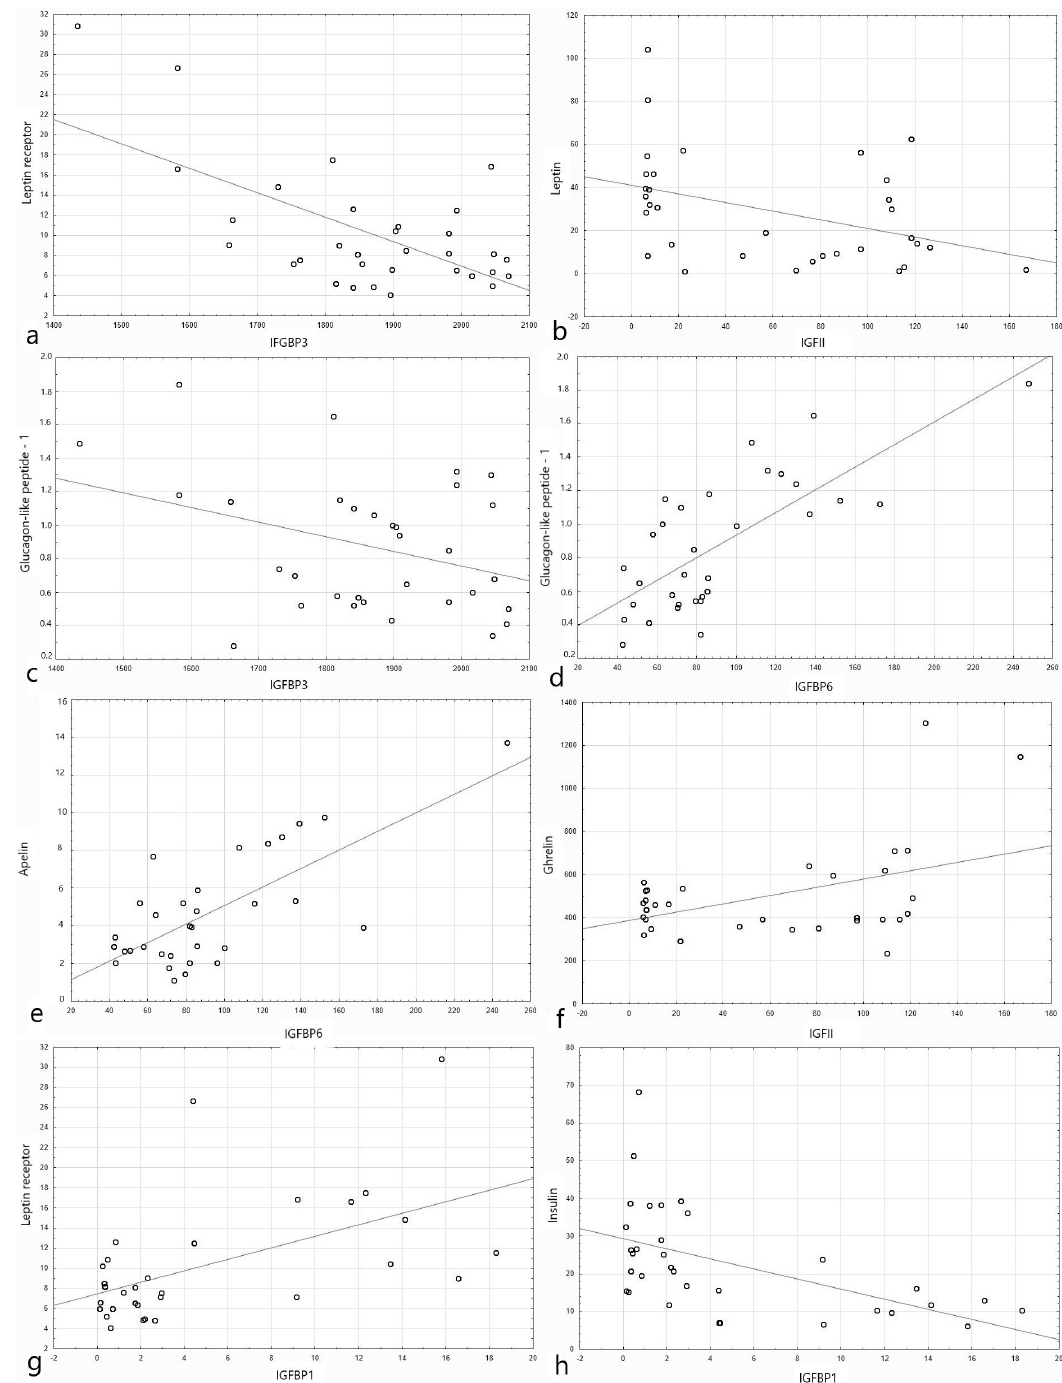
Figure 1. Plots presenting the distribution of data of the studied parameters depending on the level of different IGF family proteins’ level (shown as log2 of the absolute value of blood level for clarity of the plot). ( a ) Leptin receptor ( µ g/L) depending on the level of IGFBP3 (ng/mL). ( b ) Leptin (ng/dL) depending on the level of IGF2 (ng/mL). ( c ) Glucagon-like peptide-1 (nmol/dL) depending on the level of IGFBP3 (ng/mL). ( d ) Glucagon-like peptide-1 (nmol/dL) depending on the level of IGFBP6 (ng/mL). ( e ) Apelin (pg/mL) depending on the level of IGFBP6 (ng/mL). ( f ) Ghrelin (pg/mL) depending on the level of IGF1 (ng/mL). ( g ) Leptin receptor ( µ g/L) depending on the level of IGFBP1 (ng/mL). ( h ) Insulin ( µ IU/mL) depending on the level of IGFBP1